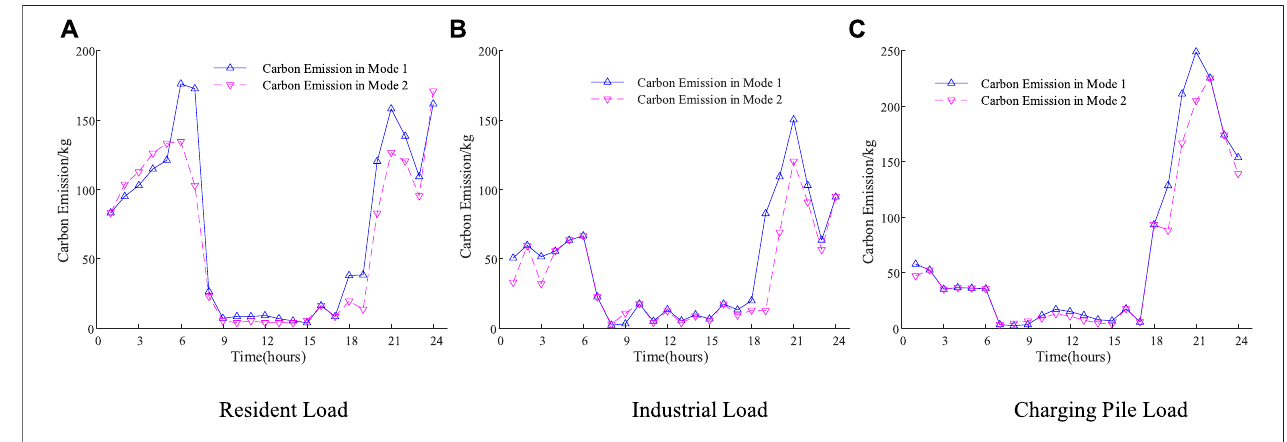
FIGURE 8 | Comparison curves of carbon emission in three scenarios under two modes.